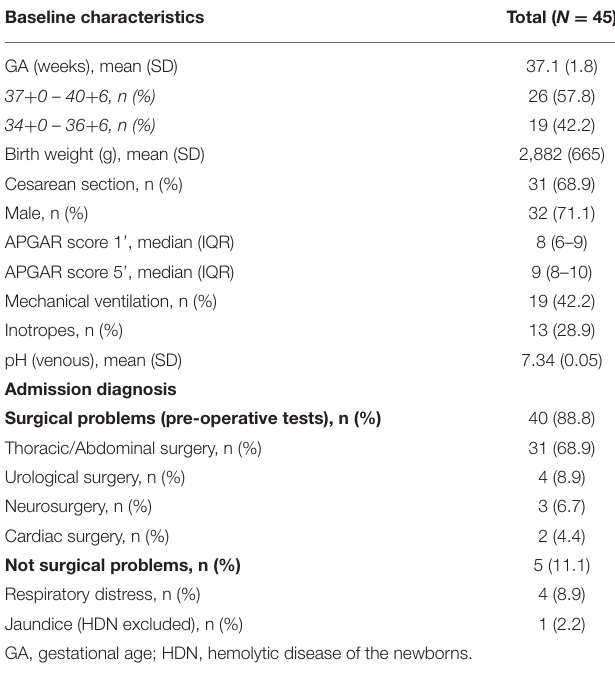
standard coagulation tests (PT, aPTT, and Fibrinogen), and venous pH were collected for each patient. For patients with more measurements available, only the first was considered. In addition, GA, weight, gender, obstetric, and perinatal anamnesis were recorded.